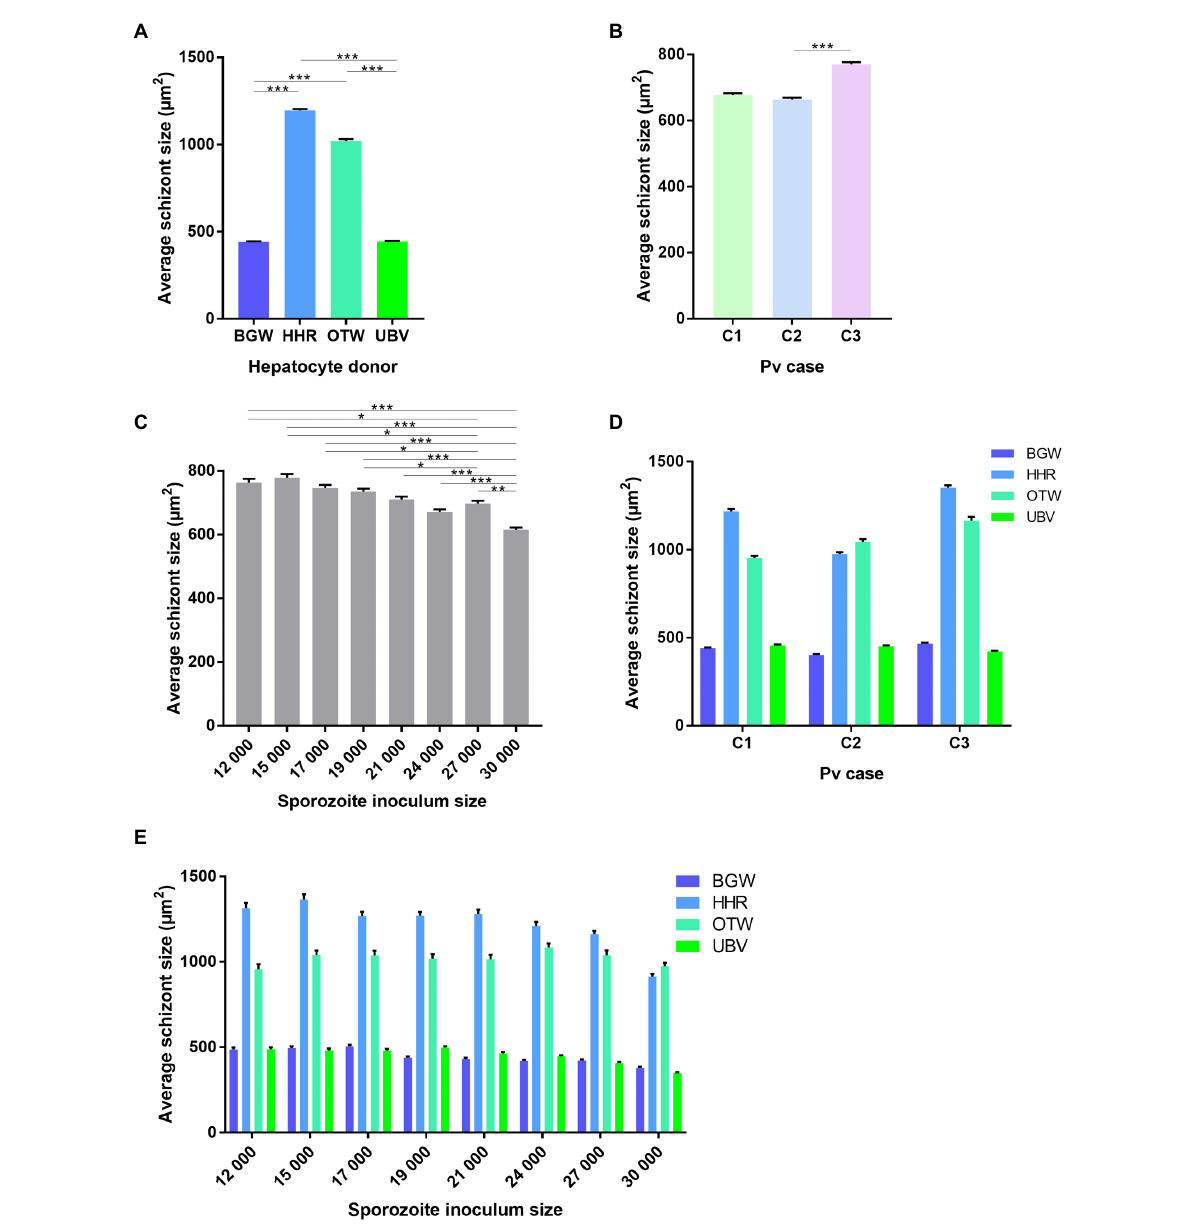
FIGURE 3 Analysis of the average size of P. vivax schizonts by PHH donor lot and P. vivax case. Data include all parasites from Experiment 1 in which four PHH donor lots (UBV, BGW, HHR, and OTW) were infected with three different P. vivax cases (C1–C3) at eight sporozoite densities ranging from 12 × 10 3 to 30 × 10 3 per well and fixed at 8 days post-infection. Data are categorized by (A) PHH donor lot, (B) P. vivax isolate, (C) sporozoite inoculum size, (D) P. vivax isolate and PHH donor lot, and (E) sporozoite inoculum size and PHH donor lot. Asterisks indicate significant differences ( Post hoc Tukey’s pairwise comparisons, *** p < 0.0001, ** p < 0.001, * p < 0.05). Bars represent ±